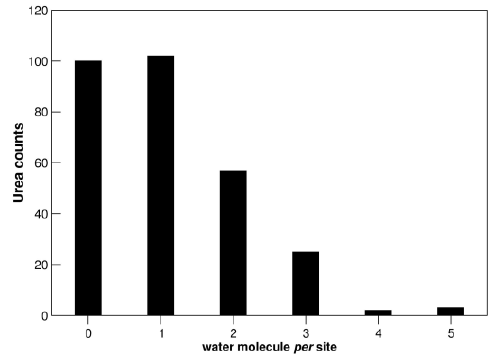
Figure 5. Distribution of water molecules per urea binding site. See also Figure S5.